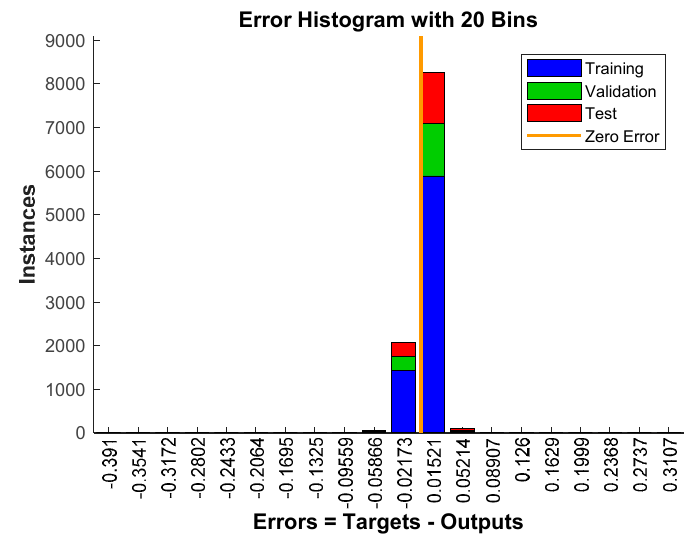
Figure 15. Neural network training error histogram plot.